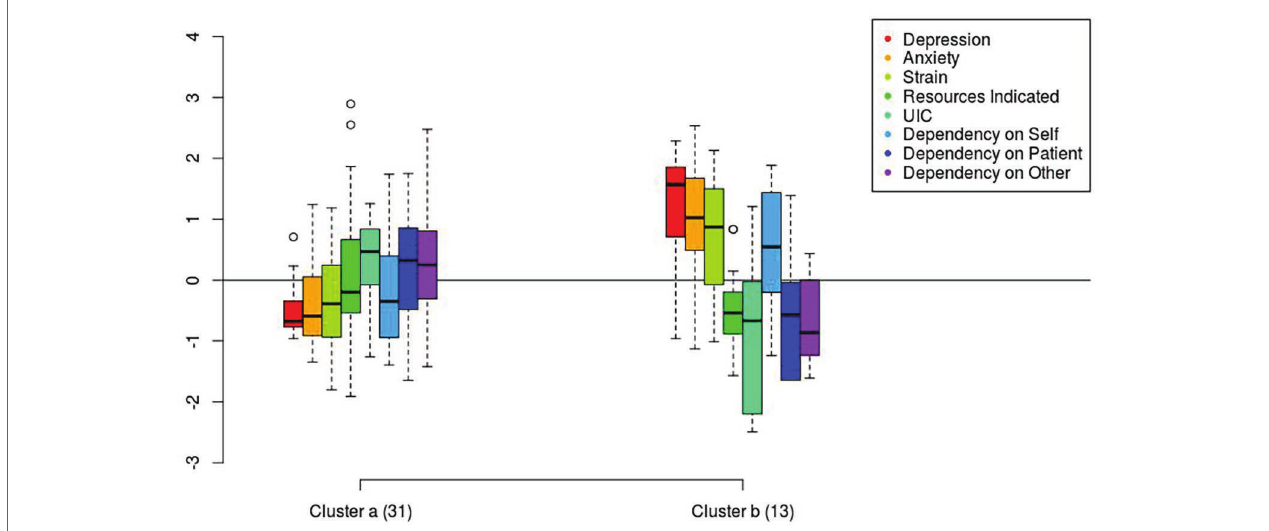
FIGURE 1 | Distribution in the two clusters of caregivers of anxiety, depression, family strain, and dependency